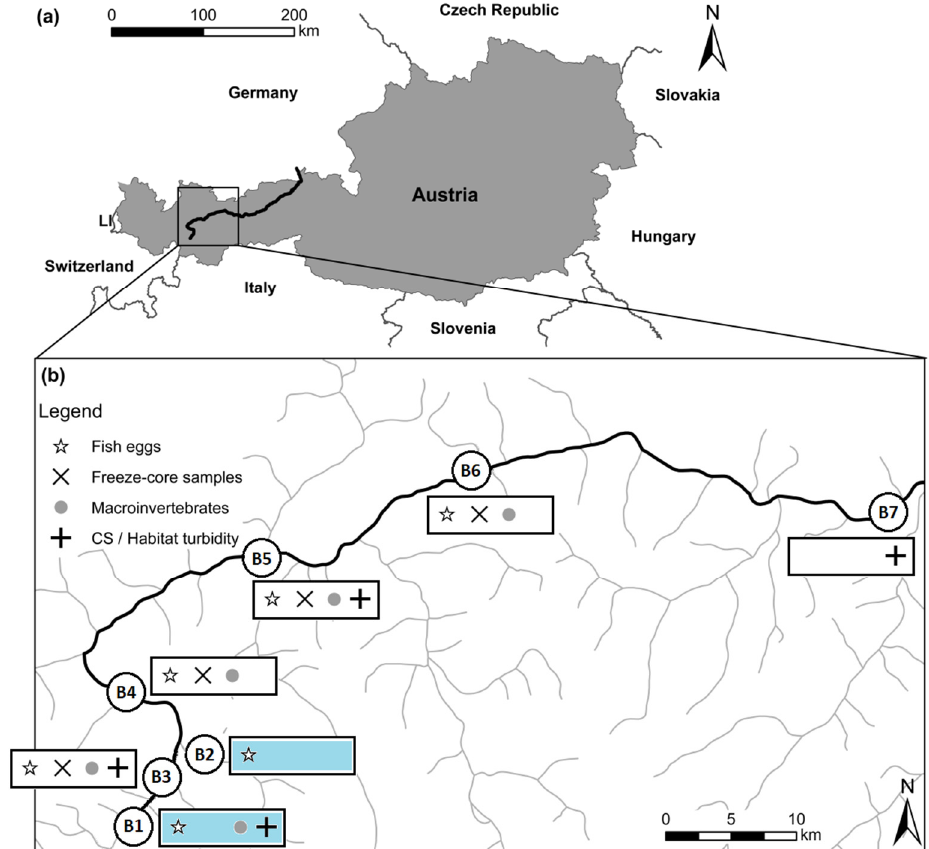
Figure 1. ( a ) Map of Austria with the sampled Inn river highlighted; ( b ) detailed map of the Inn river with highlighted investigations of macroinvertebrates and egg incubation, freeze-core samples and cross-sectional variability, and habitat-related turbidity; blue = reference sites at the Inn (B1) and the tributary Fagge (B2)